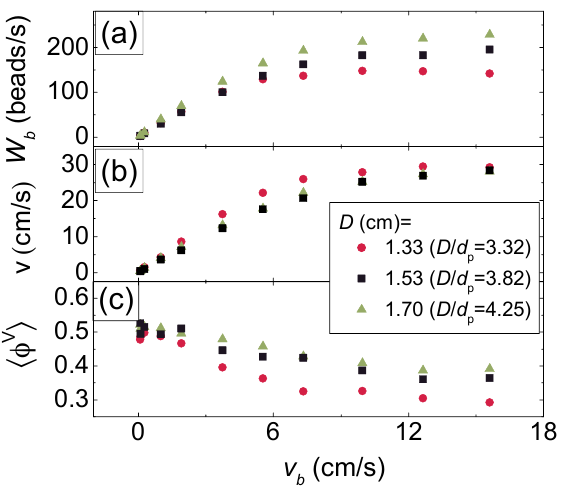
Figure 4. Experimental values of (a) the module of the mean ver- tical velocity (b) the particle flow rate and (c) the volume frac- tion, as function of the belt velocity for the three outlet sizes displayed in the